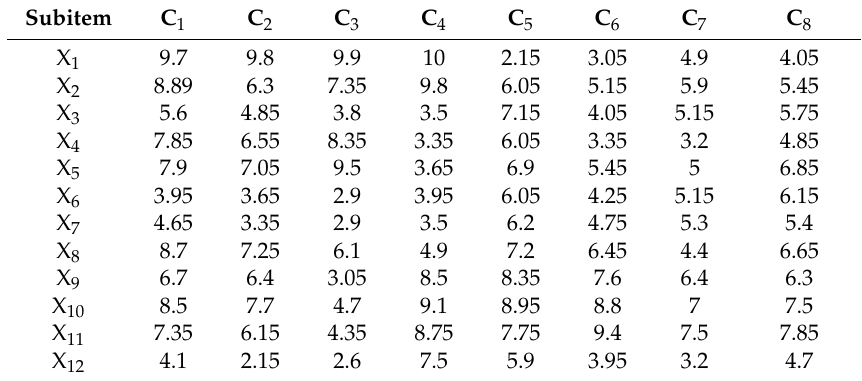
Table 2. The overall scores of the 8 Level 3 indices of the 12 classes of flood control materials. Subitem C 1 C 2 C 3